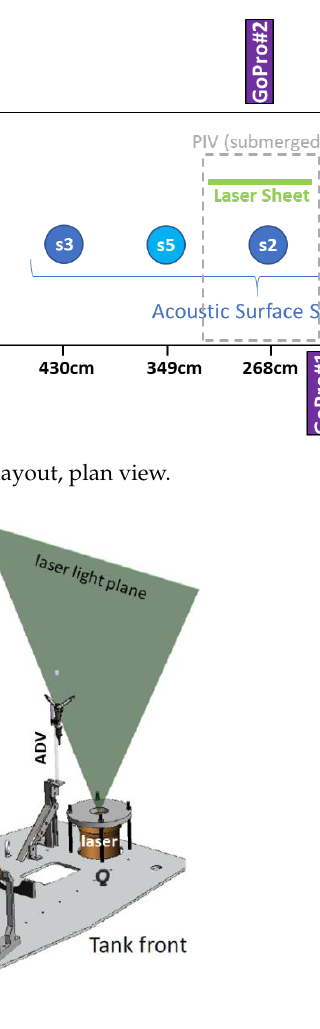
Figure 2. Diagram of PIV configuration (central processing module not shown).